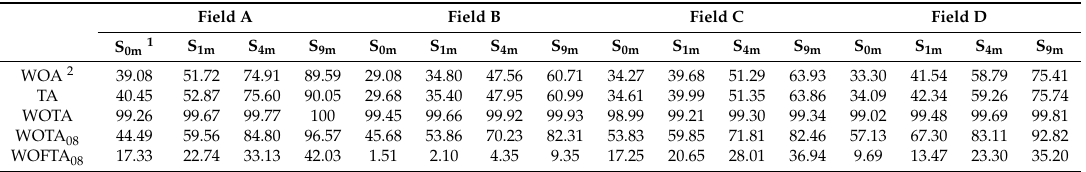
Table 3. Comparison of the treated areas considering simulations form S 0m to S 9m in the four wheat fields. Field A Field B Field